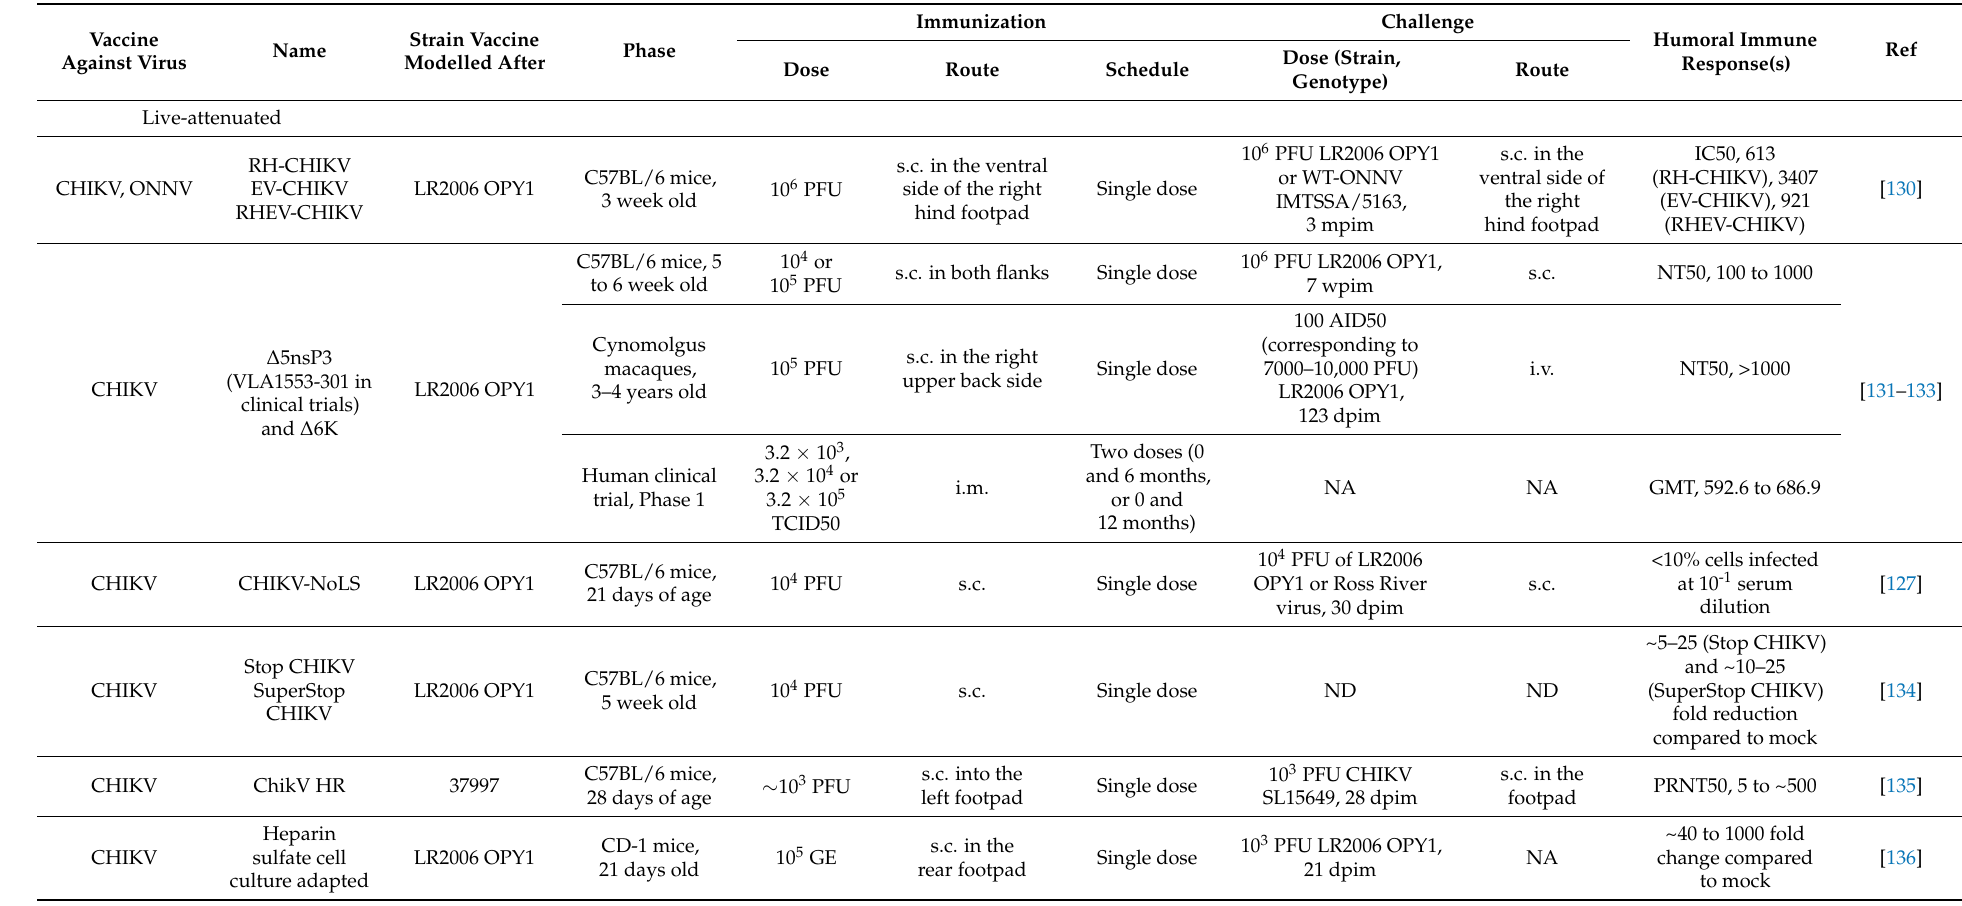
Table 1. List of vaccine candidates against relevant alphaviruses currently under development 1